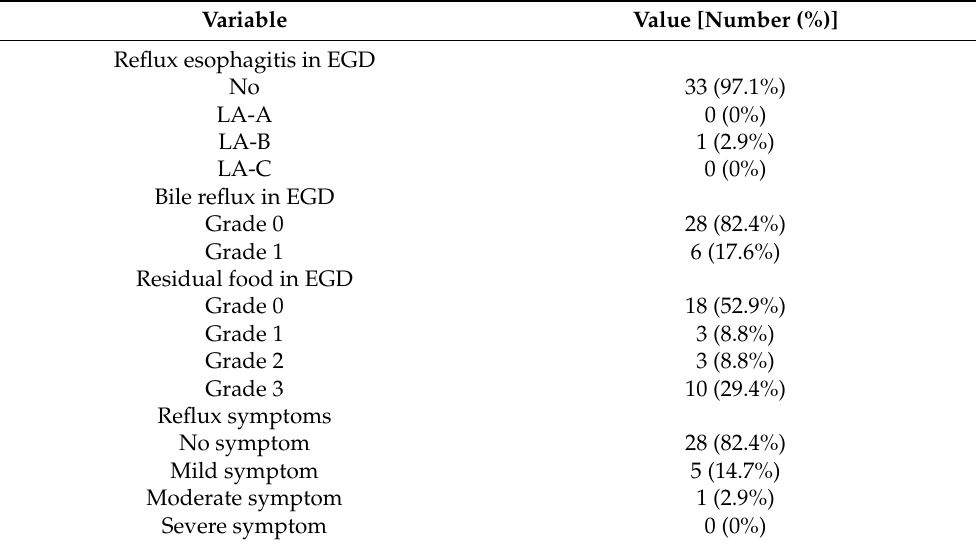
Table 2. Postoperative endoscopic findings and reflux symptom in 1 year follow-up.